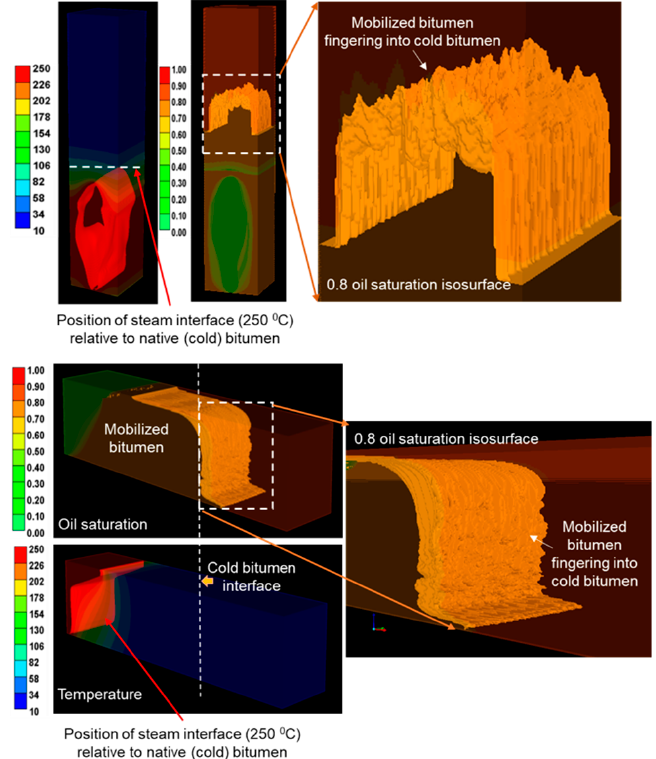
Figure 14. 3D images of the temperature and oil saturation isosurfaces of the VE (top) and HE (bottom) models respectively. The red isosurfaces are at 250 °C indicating the steam saturation boundary. The orange isosurfaces marks the 0.8 oil saturation indicating the mobile oil boundary. The enlarged images on the right show fingering of the mobilized (warm) bitumen into the cold (native) bitumen.